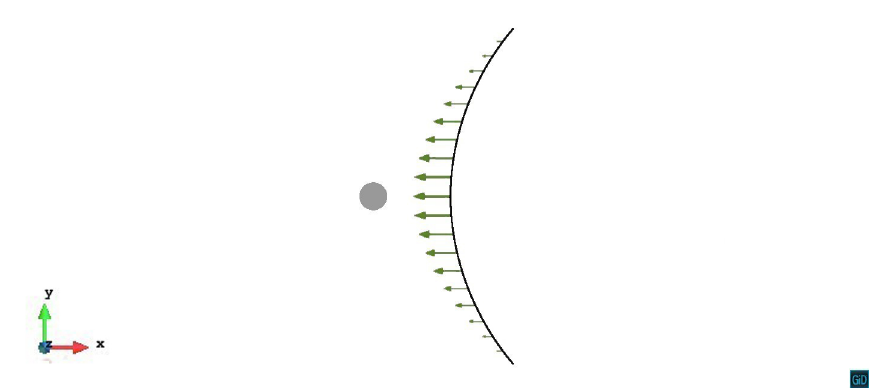
Figure 9. The dislocation topology and nodal force vectors in z / R = − 0.2 case. The plastic strain ε = 2.23 × 10 − 5